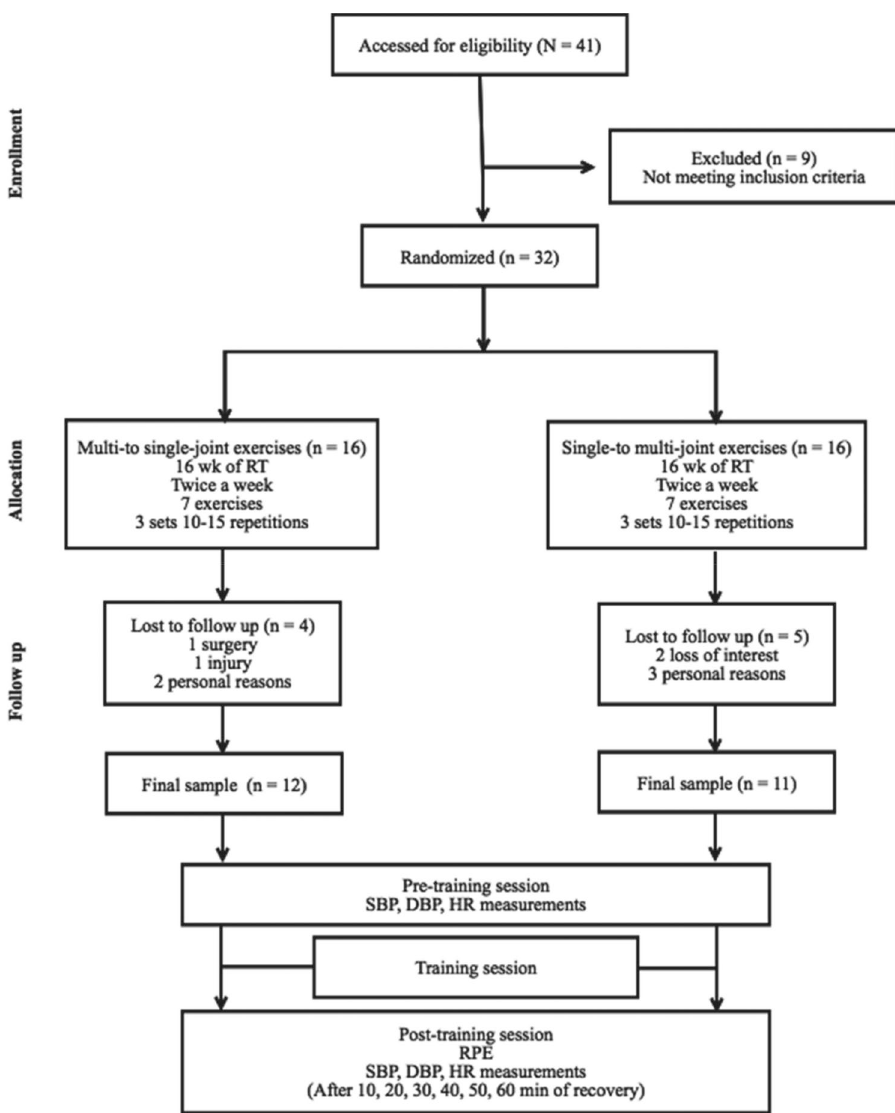
Figure 1 - Experimental design